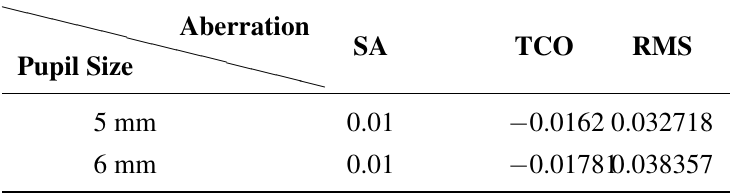
Table 8. Third-order aberrations after applying the built-in optimization method in CODE